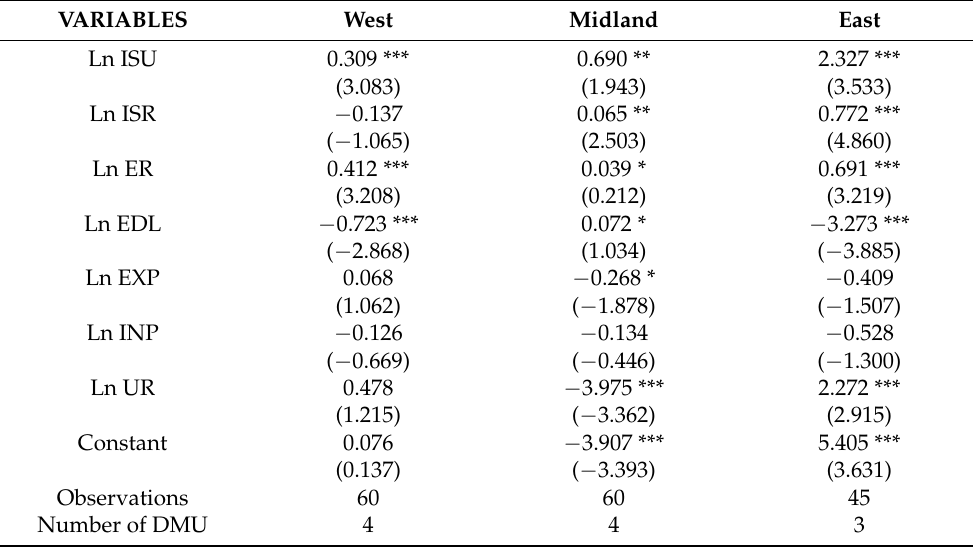
Table 6. Regression results of the impact of subregional industrial structure on GTFP.